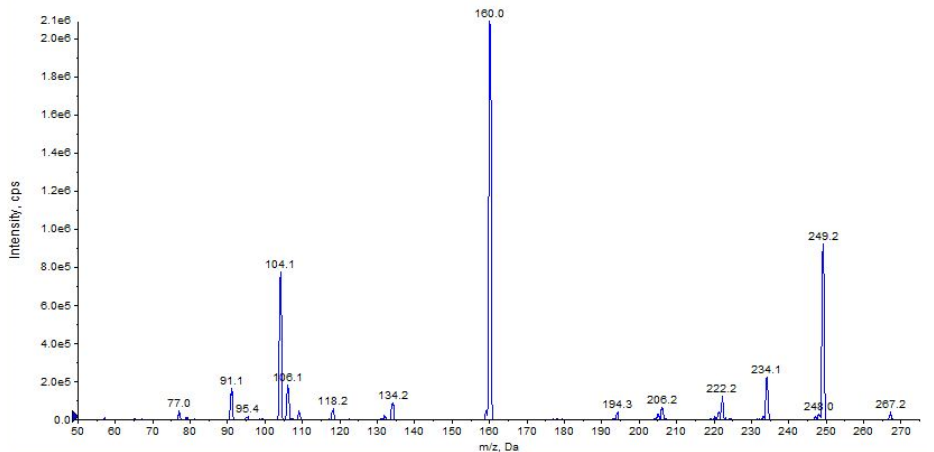
Figure 15 . Product ion scan of URB754 compound obtained by QqQ. Exponential scale to base 10.